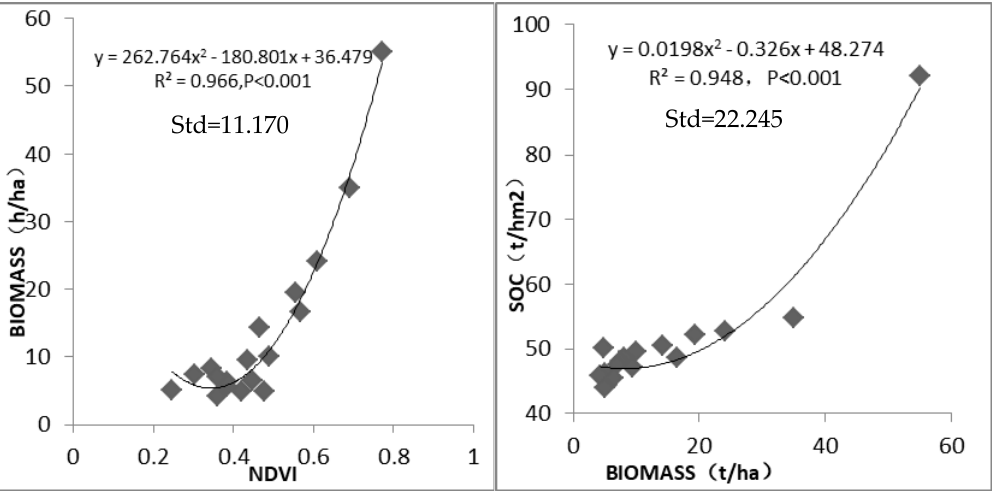
Figure 1. Biomass-NDVI and SOC-NDVI regression analyses.